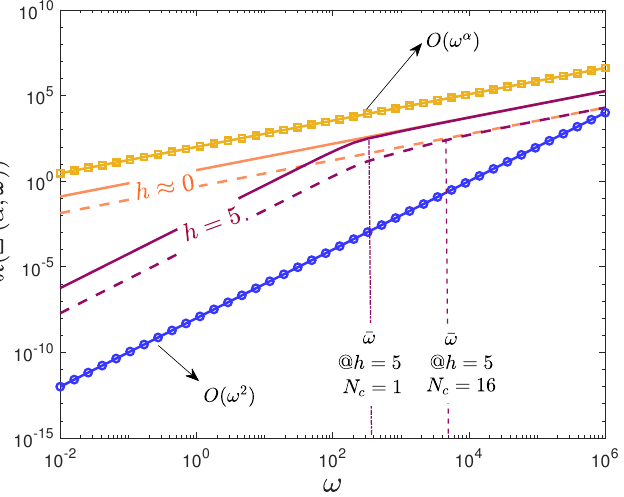
Figure 11. Real part of the Ξ ( α , ω ) (cid:48) vs. ω for 2 b = 2.6 and λ = 1m − 2 , comparing the UCA with single antenna. The two guidelines are parallel with ω α and ω 2 : Solid lines correspond to a point antenna while dashed lines correspond to a UCA with N c = 16 isotropic antennas on a